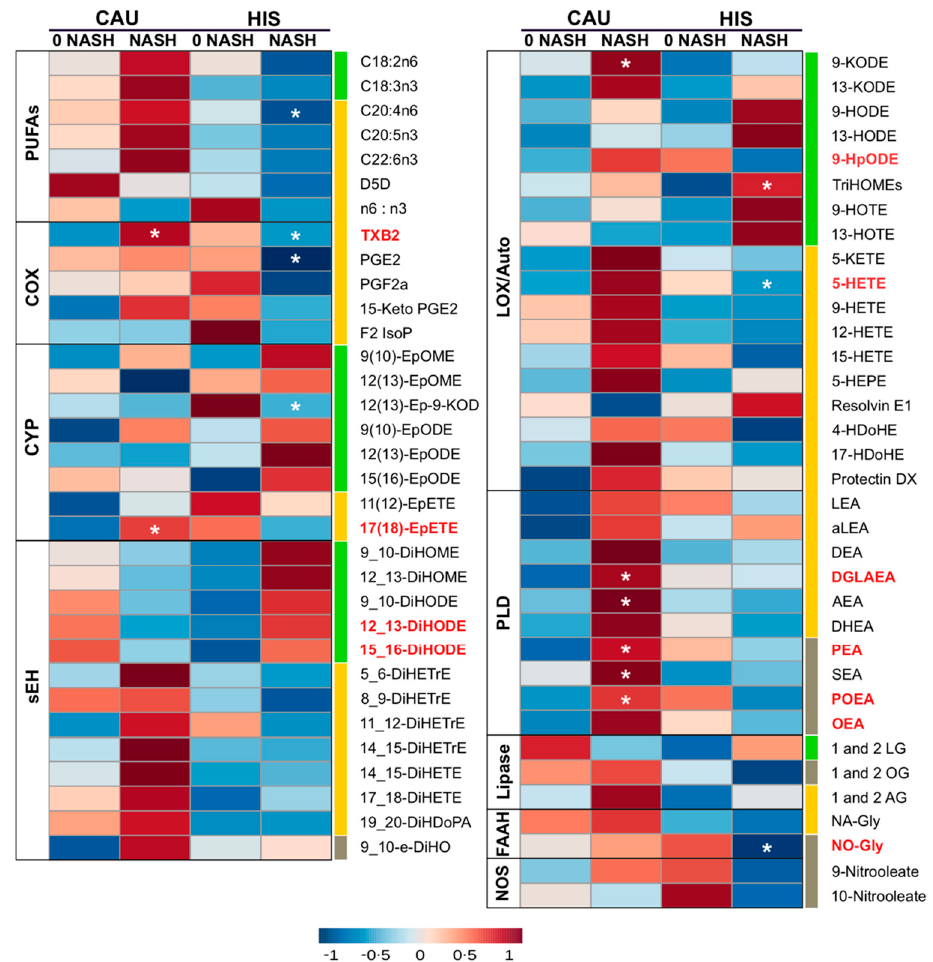
Figure 2. Heatmap illustrating fold changes and differences in plasma polyunsaturated fatty acids (PUFAs) and lipid mediators between non-alcoholic steatohepatitis (NASH) compared to NASH-free (0-NASH) in primary cohort. Fold changes are indicated by color and intensity, with red indicating an increase, and blue indicating a decrease. Lipids different in NASH vs. 0-NASH ( t -test raw p < 0.05) are noted by (*). Ethnicity-related differences, or interaction (ethnicity × NASH) (ANCOVA raw p < 0.05) are marked with bold red color. C18 PUFAs and related lipids are marked with “green”; long chain-PUFAs and related lipids are marked with “yellow”; saturated fatty acids (SFA) and monounsaturated fatty acid (MUFA) related lipids are marked with “grey”. Means and p -values are detailed in Table S3. Fatty acids are described by number of carbons and double bounds of the fatty acyl moiety (i.e., C18:2n6). NASH ( n = 6 Hispanic (HIS) and 3 Caucasian (CAU); 0-NASH ( n =